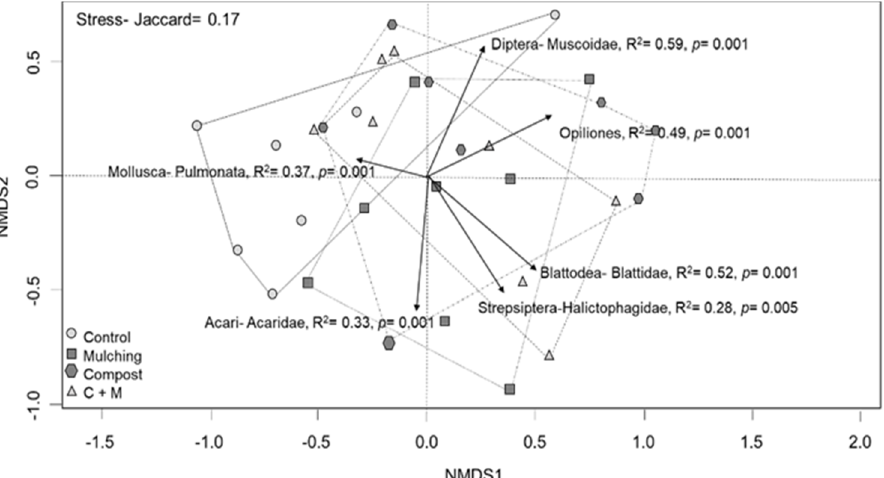
Figure 4. Non-metric multidimensional scaling (NMDS) based on soil organisms’ composition among the studied organic residue management in a 16-year P. pyrifolia field. Organic residue management are represented as follows: Control = circles; mulching = squares; compost = hexagon; and compost plus mulching = triangles.